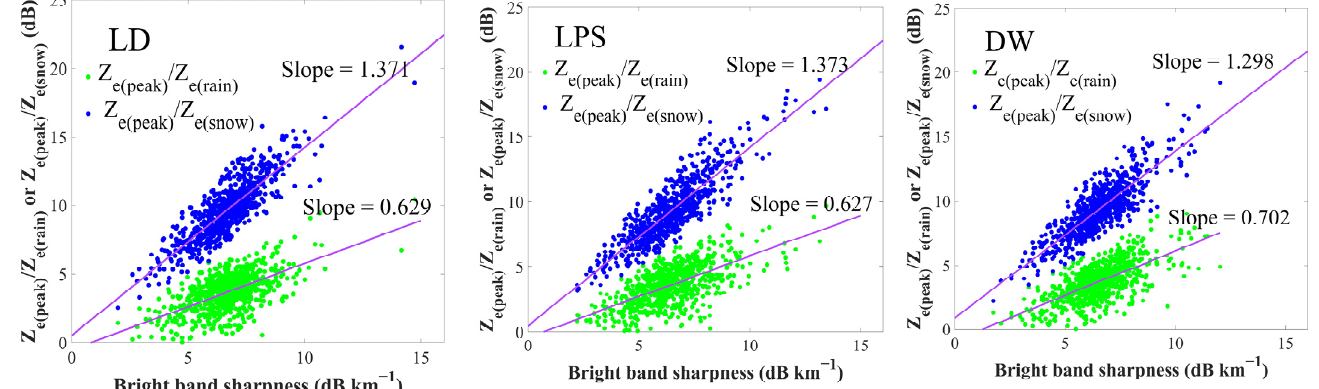
Figure 8. As in Figure 7 except for the daily mean BB sharpness (BB sh ) versus the ratio of Z e (peak) / Z e (rain) or Z e (peak) / Z e (snow) at LD, LPS, and DW.